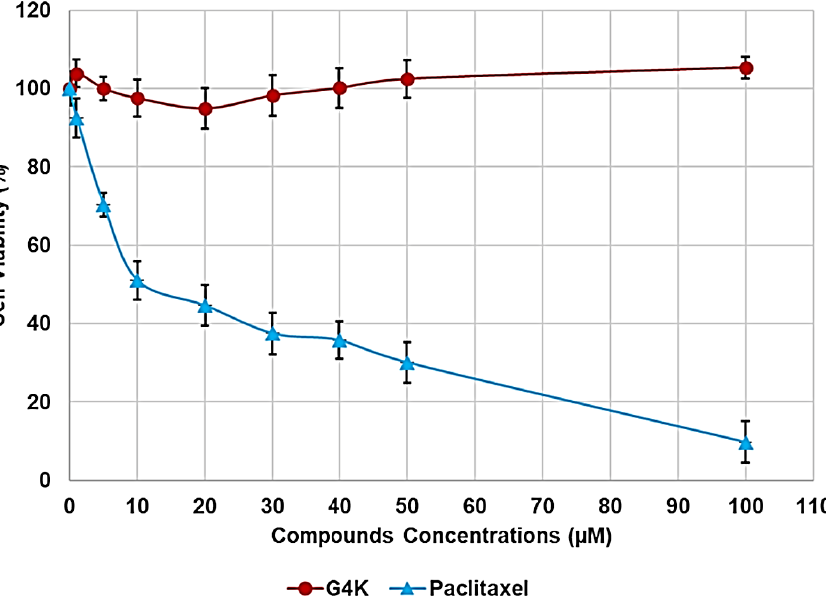
Figure 3. Cell viability (%) of HeLa cells exposed for 24 h to G4K and paclitaxel at concentration 0 – 100 µM. Table 1. Cytotoxicity data of some pyrazole derivatives on different human cancer cell lines and normal cells lines found in the